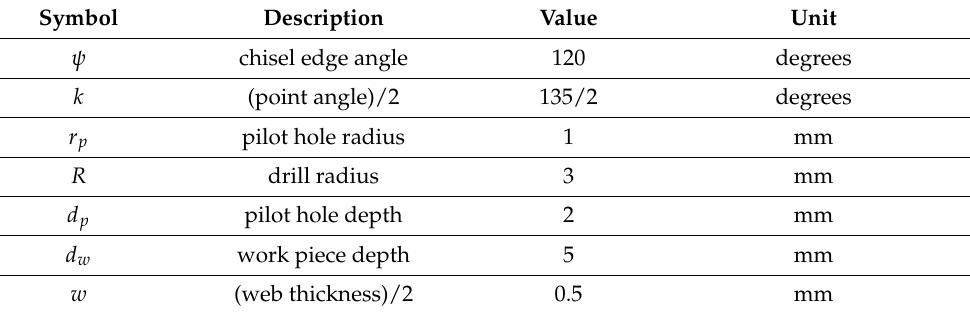
Table 1. Drill geometric